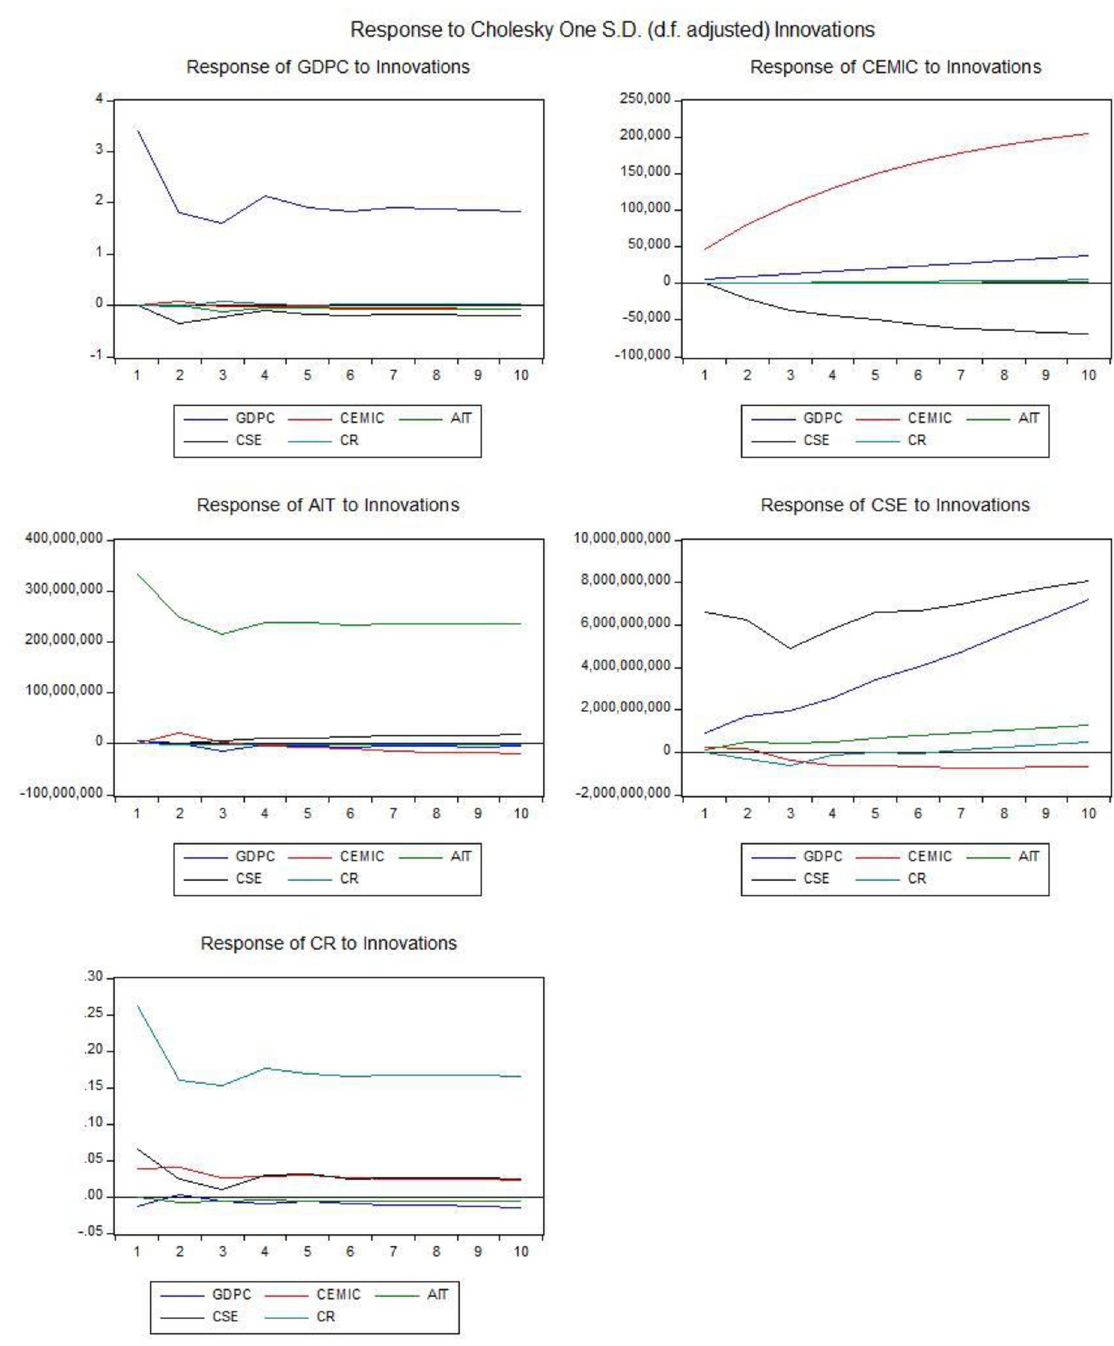
Fig 7. Impulse response. Source: Authors’